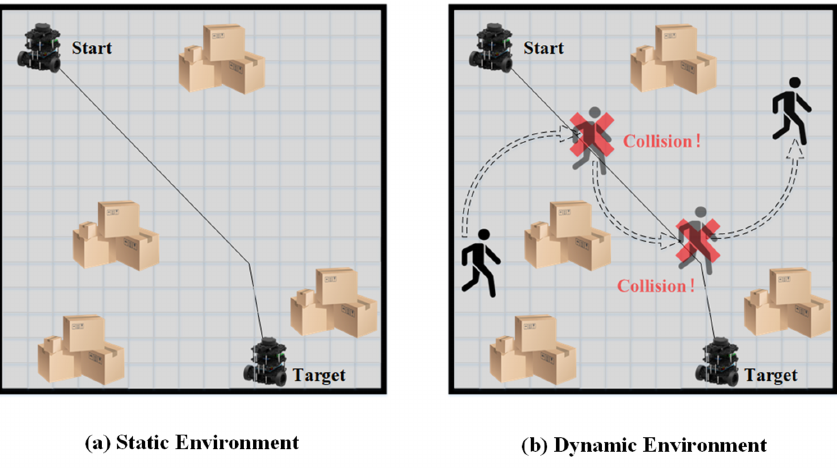
Figure 1. Problem of Global Path Planning in Dynamic